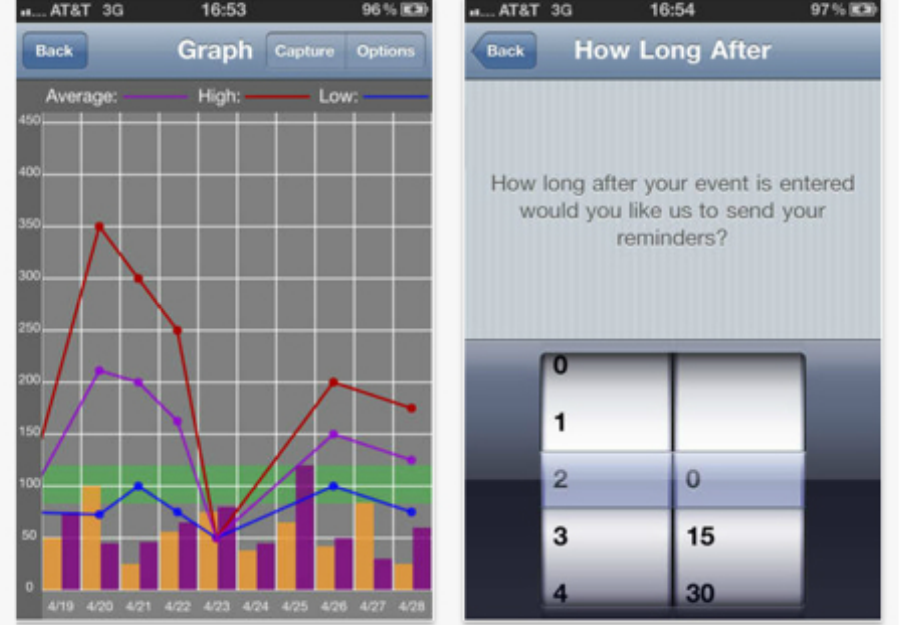
Figure 3. Glucose Buddy screenshots of the graphic display of logs and option to set up